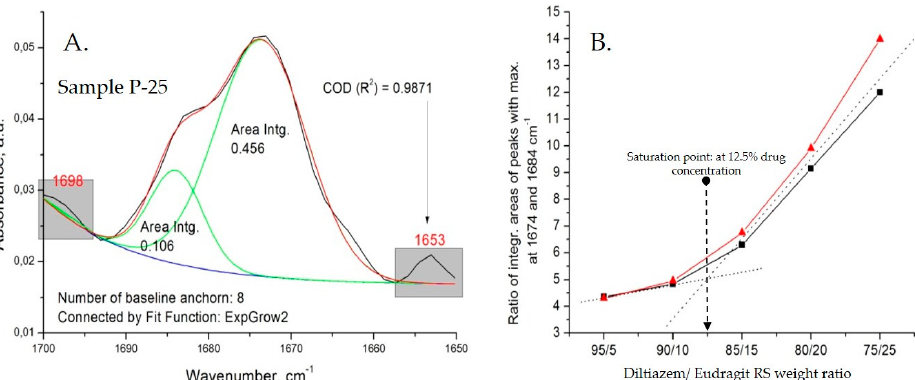
Figure 5. Deconvolution analysis in the C=O (lactamic) stretching vibrations range for physical drug–polymer mixtures (P models); ( A ) an example for deconvolution analysis carried on Sample P-25 spectrum (the same analysis is carried for all other samples-Tables A1–A10, Appendix A) and ( B ) determination of drug-saturation point of the polymer matrix by the physical-mixing approach; the curve in red presents optimized processing of the deconvolution analysis data, in which the cause for the low regression coefficient (R 2 )–a peak at 1653 cm − 1 , is not taken into account .